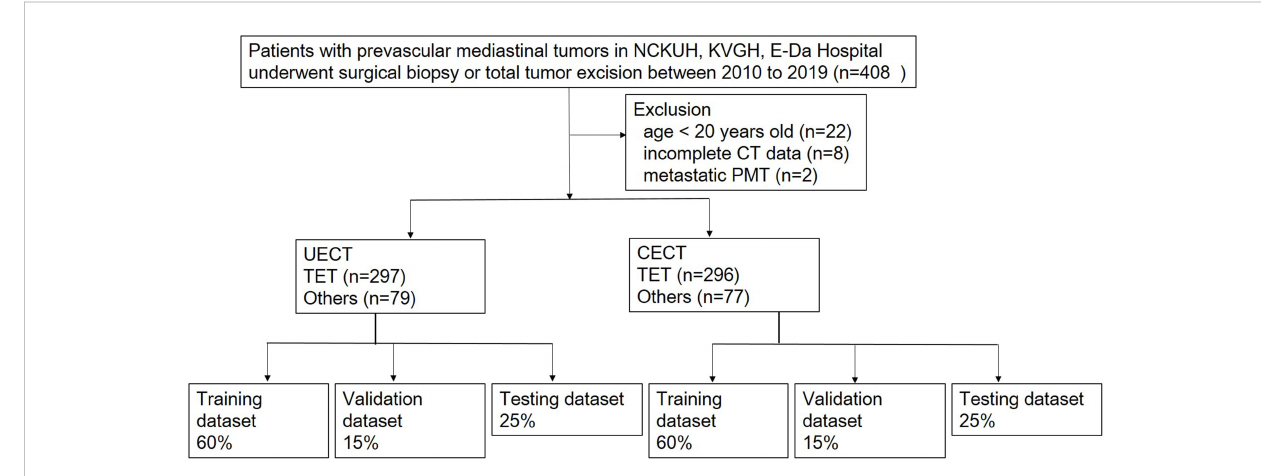
FIGURE 1 Flowchart of patients inclusion. NCKUH, National Cheng Kung University Hospital; KVGH, Kaohsiung Veteran General